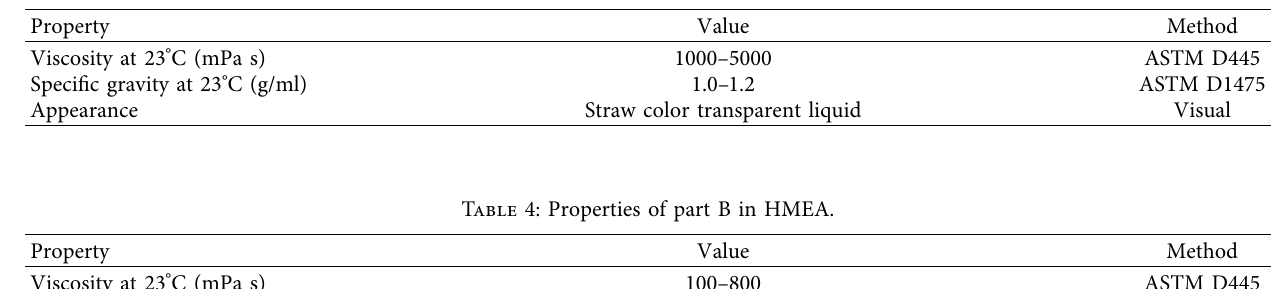
Table 3: Properties of part A in HMEA.